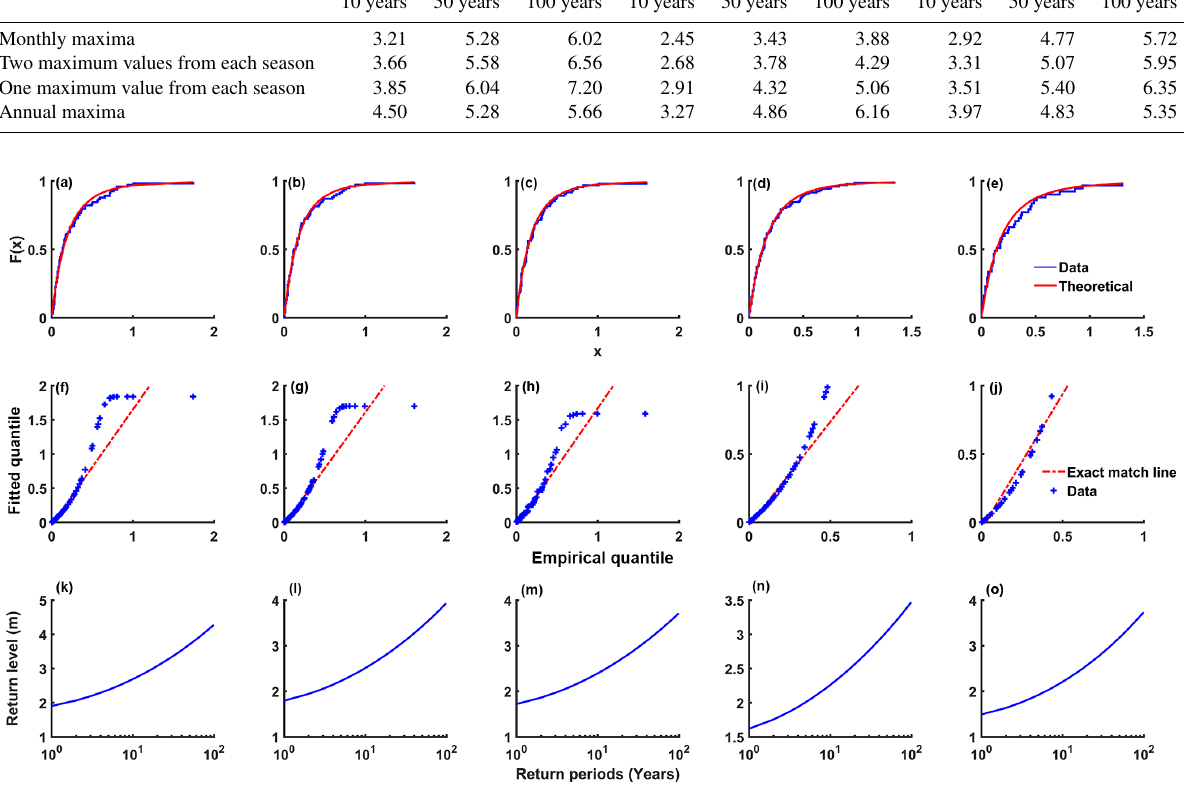
Figure 7. Same as in Fig. 4 but corresponding to the post-monsoon